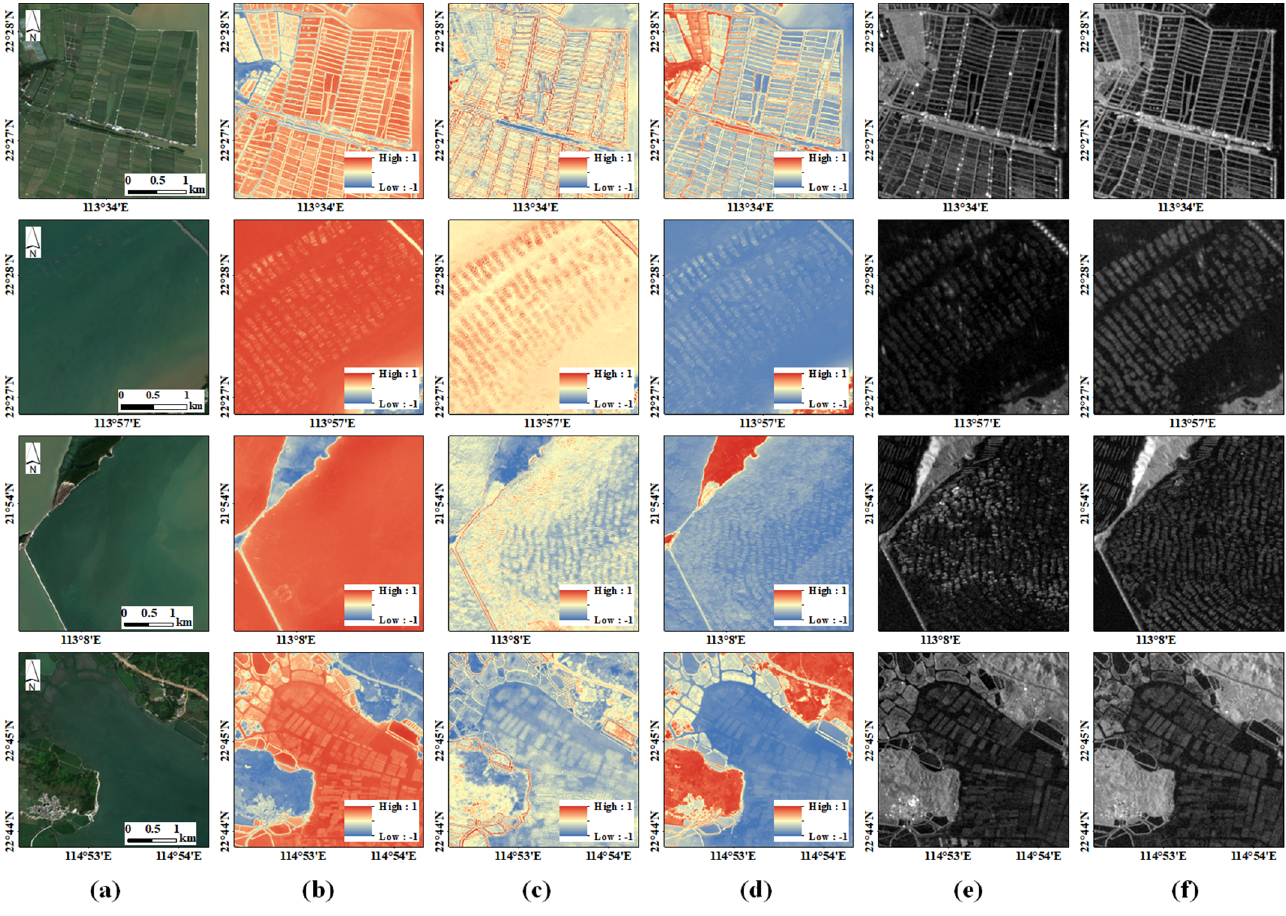
Figure 3. Images and features of typical aquaculture areas: ( a ) Sentinel-2A multispectral image, ( b ) NDWI, ( c ) NDBI, ( d ) NDVI, ( e ) VV Polarization image, and ( f ) VH Polarization image.